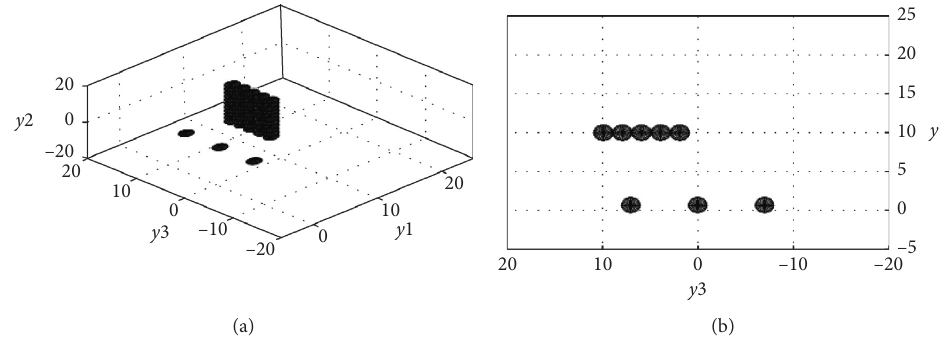
Figure 32: Initial positions of the obstacles and the group of AMR: ( a ) 3D view; (b) plan